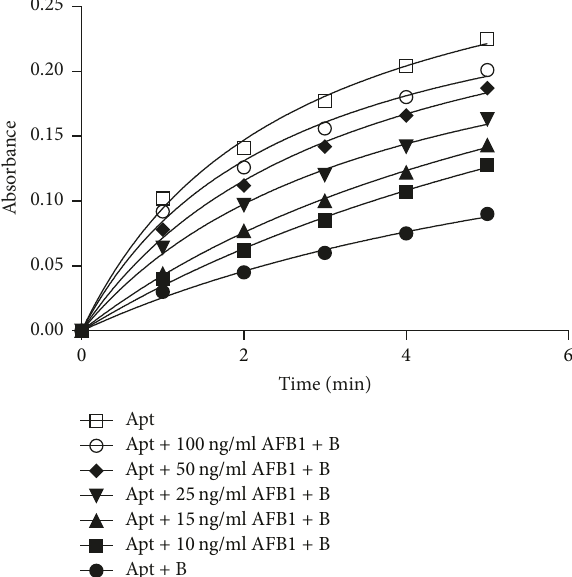
Figure 4: Peroxidase activity of DNAzyme-aptamer in the presence ofB3anddifferentconcentrationsofAFB1.Apt:DNAzyme-aptamer, B: blocker complementary sequence, and AFB1: aflatoxin